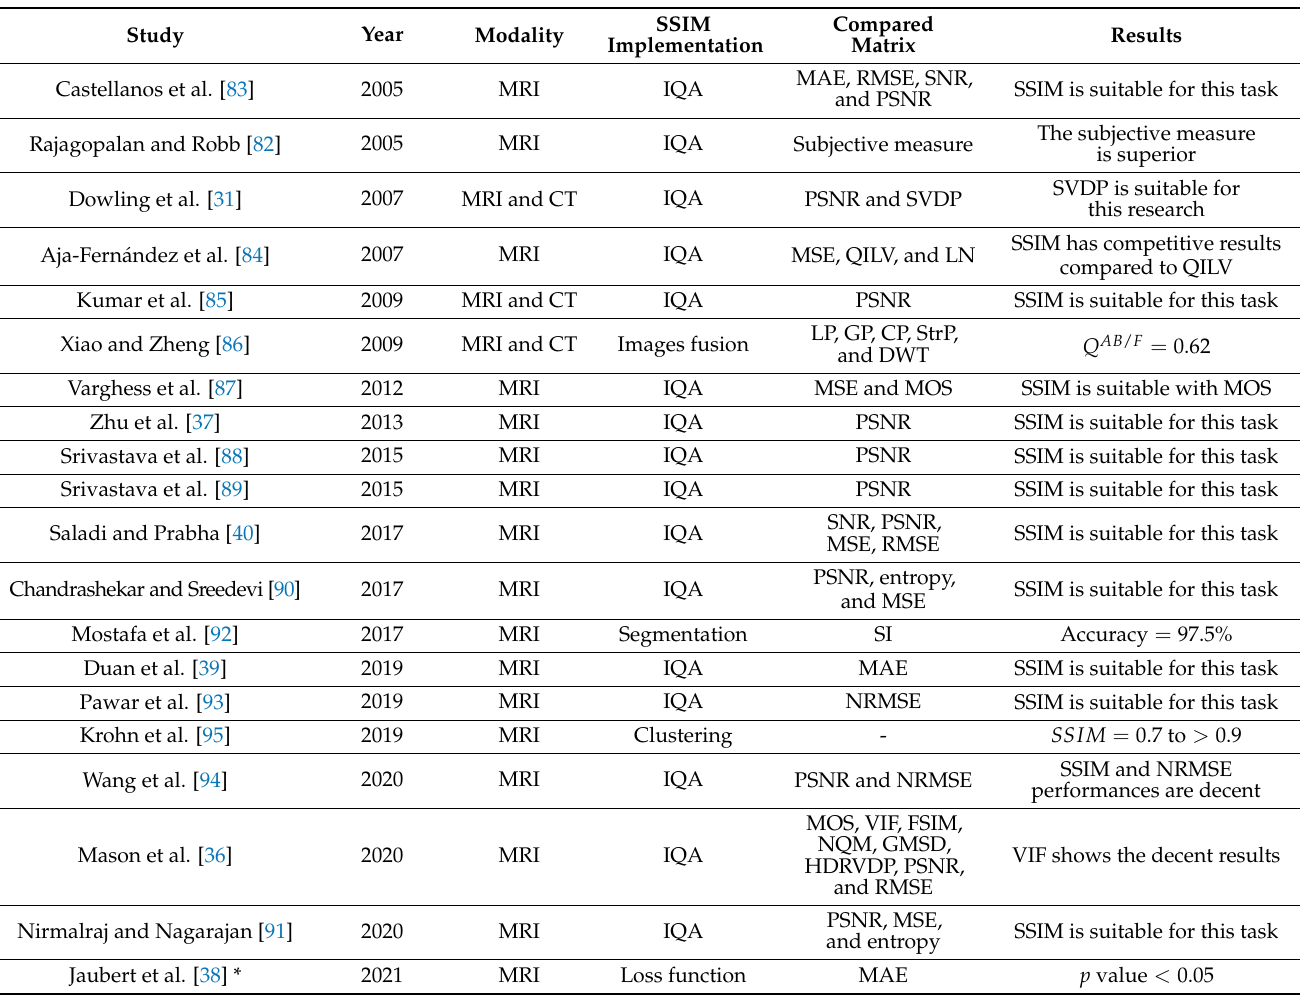
Table 1. Summary of published articles encompassing SSIM for MRI. MRI, magnetic resonance imaging; CT, computed tomography; MAE, mean-absolute error; RMSE, root-mean-square error; SNR, signal-to-noise ratio; PSNR, peak-signal-to-noise ratio; SVDP, steerable visual difference predictor; QILV, quality index based on local variance; LN, level on noise; LP, Laplacian pyramid; GP, gradient pyramid; CP, contrast pyramid; StrP, steerable pyramid; DWT, discrete wavelet transform; Q AB / F , visual information quality; MOS, mean opinion score; SI, similarity index; NRMSE, normalized- root-mean-square error; VIF, visual information fidelity; FSIM, feature similarity index; NQM, noise quality metric; GMSD, gradient magnitude similarity deviation; HDRVDP, high dynamic range visible difference predictor; CNN, convolutional neural